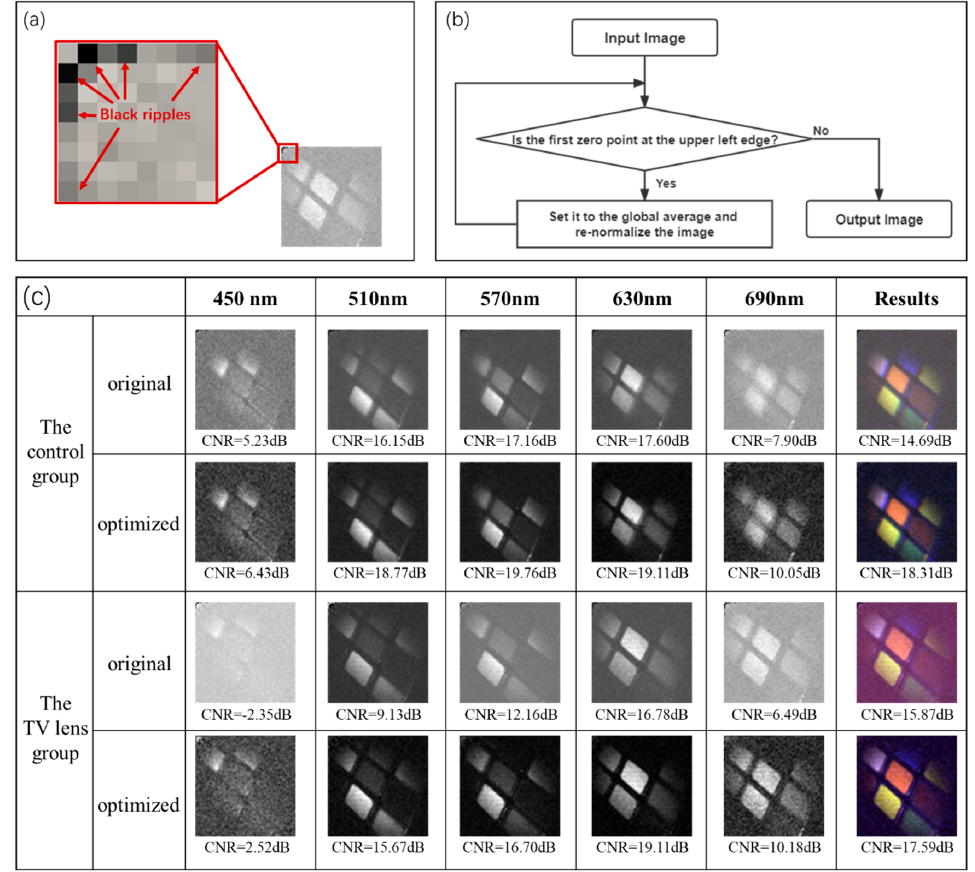
Figure 6. Proposed adaptive iterative correction algorithm. ( a ) The noise ripples (zero points) on the upper-left edge. ( b ) The adaptive iterative correction algorithm used to correct the erroneous black noise ripples. ( c ) Comparison of SPI images in different spectral bands before and after correction.